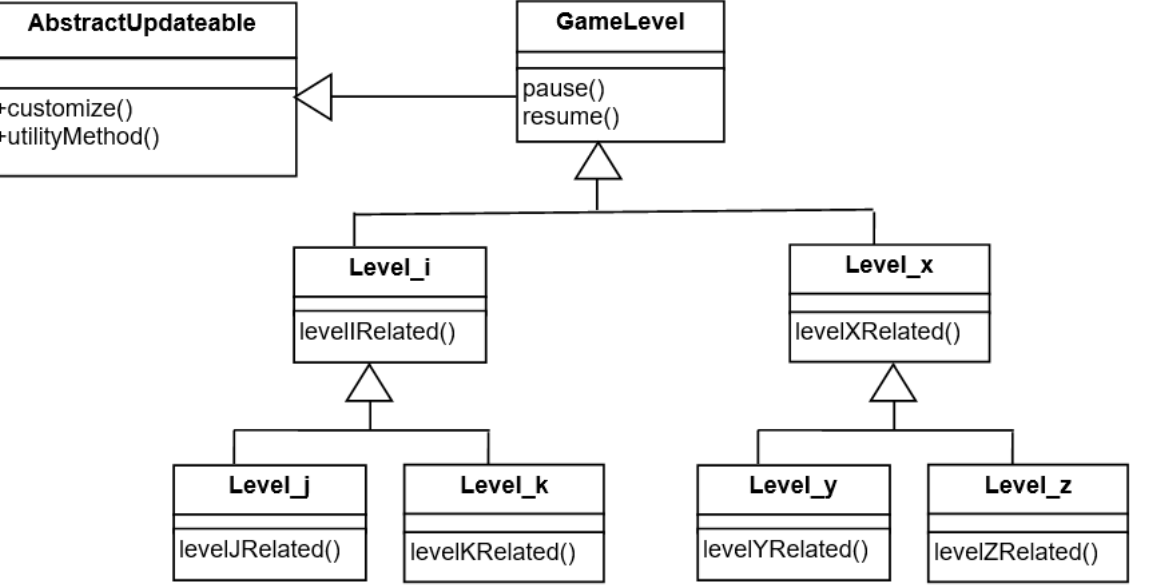
Figure 12. Related Levels pattern with default approach.